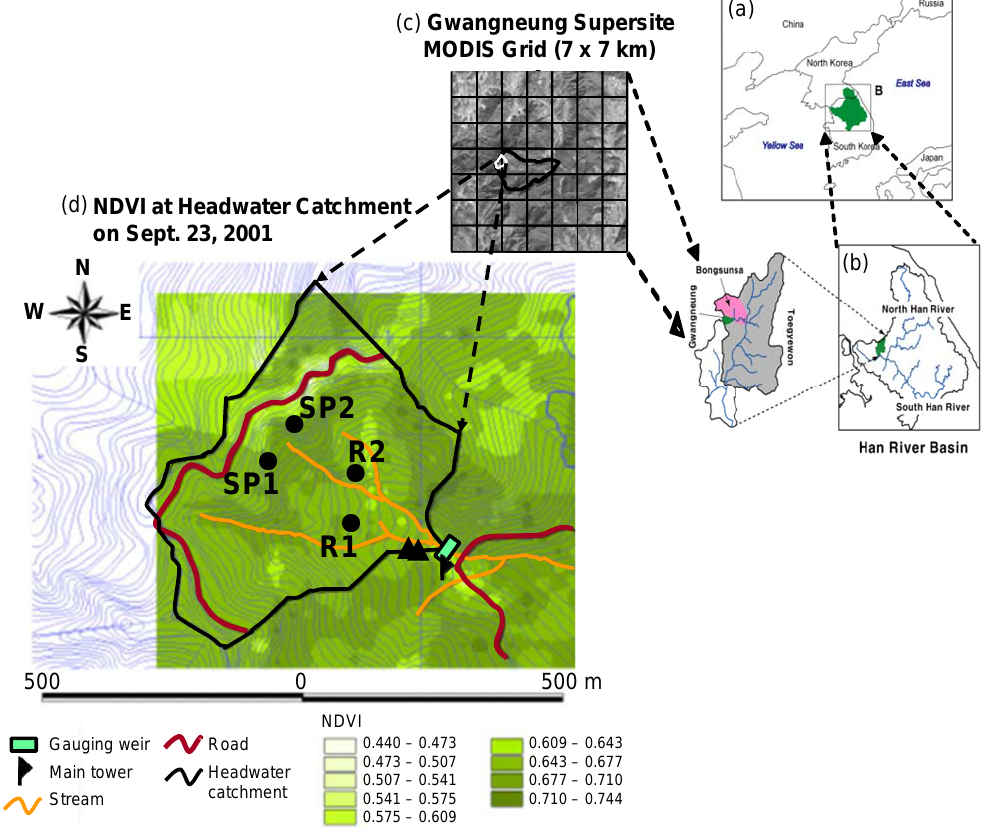
Fig. 1. Maps showing (a) the location of the Han River basin, (b) the location of the Gwangneung catchment, (c) the topography of the Gwangneung catchment, and (d) normalized difference vegetation index of the headwater catchment (22 ha). Black circles indicate the locations of tension free lysimeters and groundwater wells. Black triangles indicate the locations of water-filled porosity measurement.